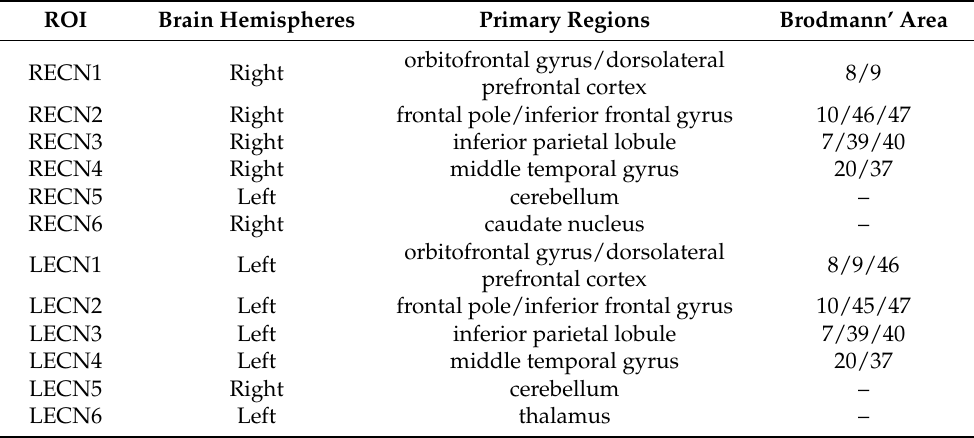
Table 1. Twelve ROIs of executive control